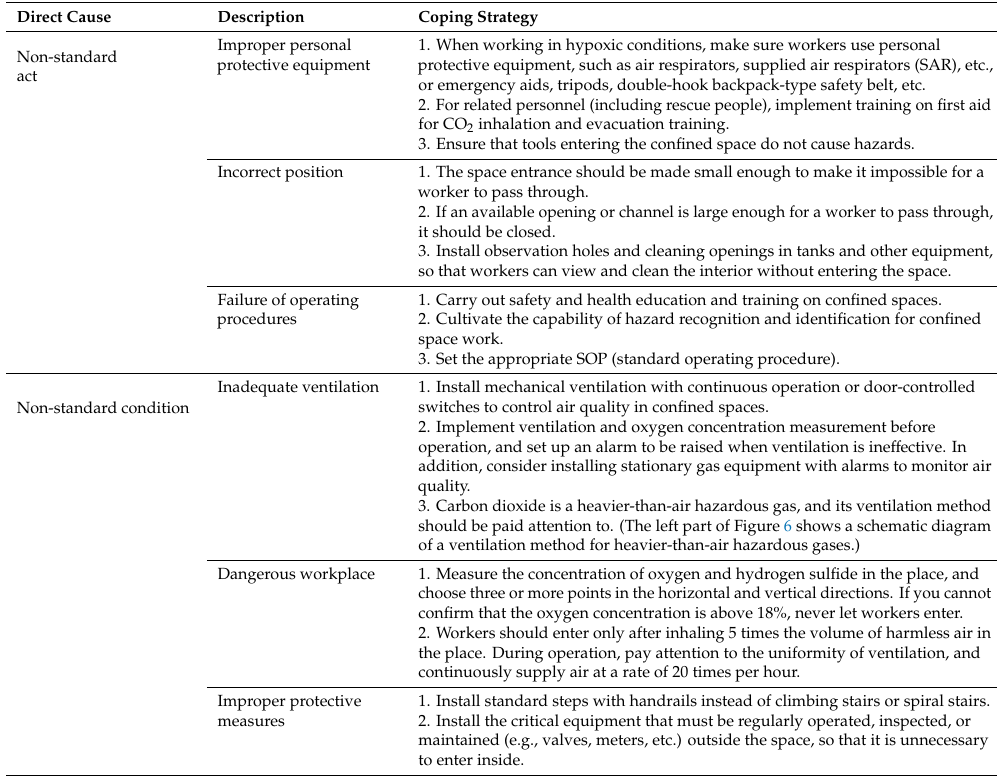
Figure 6. Schematic diagram of a ventilation method for a heavier-than-air hazardous gas (left) and a lighter-than-air hazardous gas (right). Table 7. Coping strategies for preventing confined space accidents due to carbon